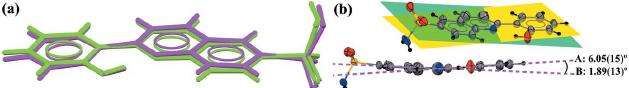
Figure 2 ( a ) Overlay image of the two molecules in the asymmetric unit of the title compound. ( b ) Dihedral angles between the quinoline and the phenol moieties in the title compound.